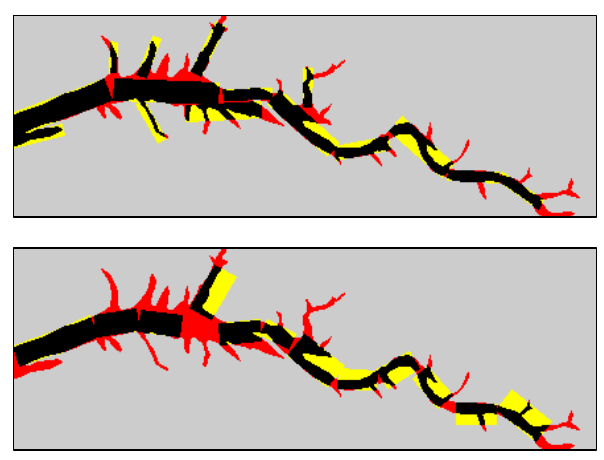
Figure 9. Result for the whole test site (black = TP, yellow = FP, red = FN, gray =